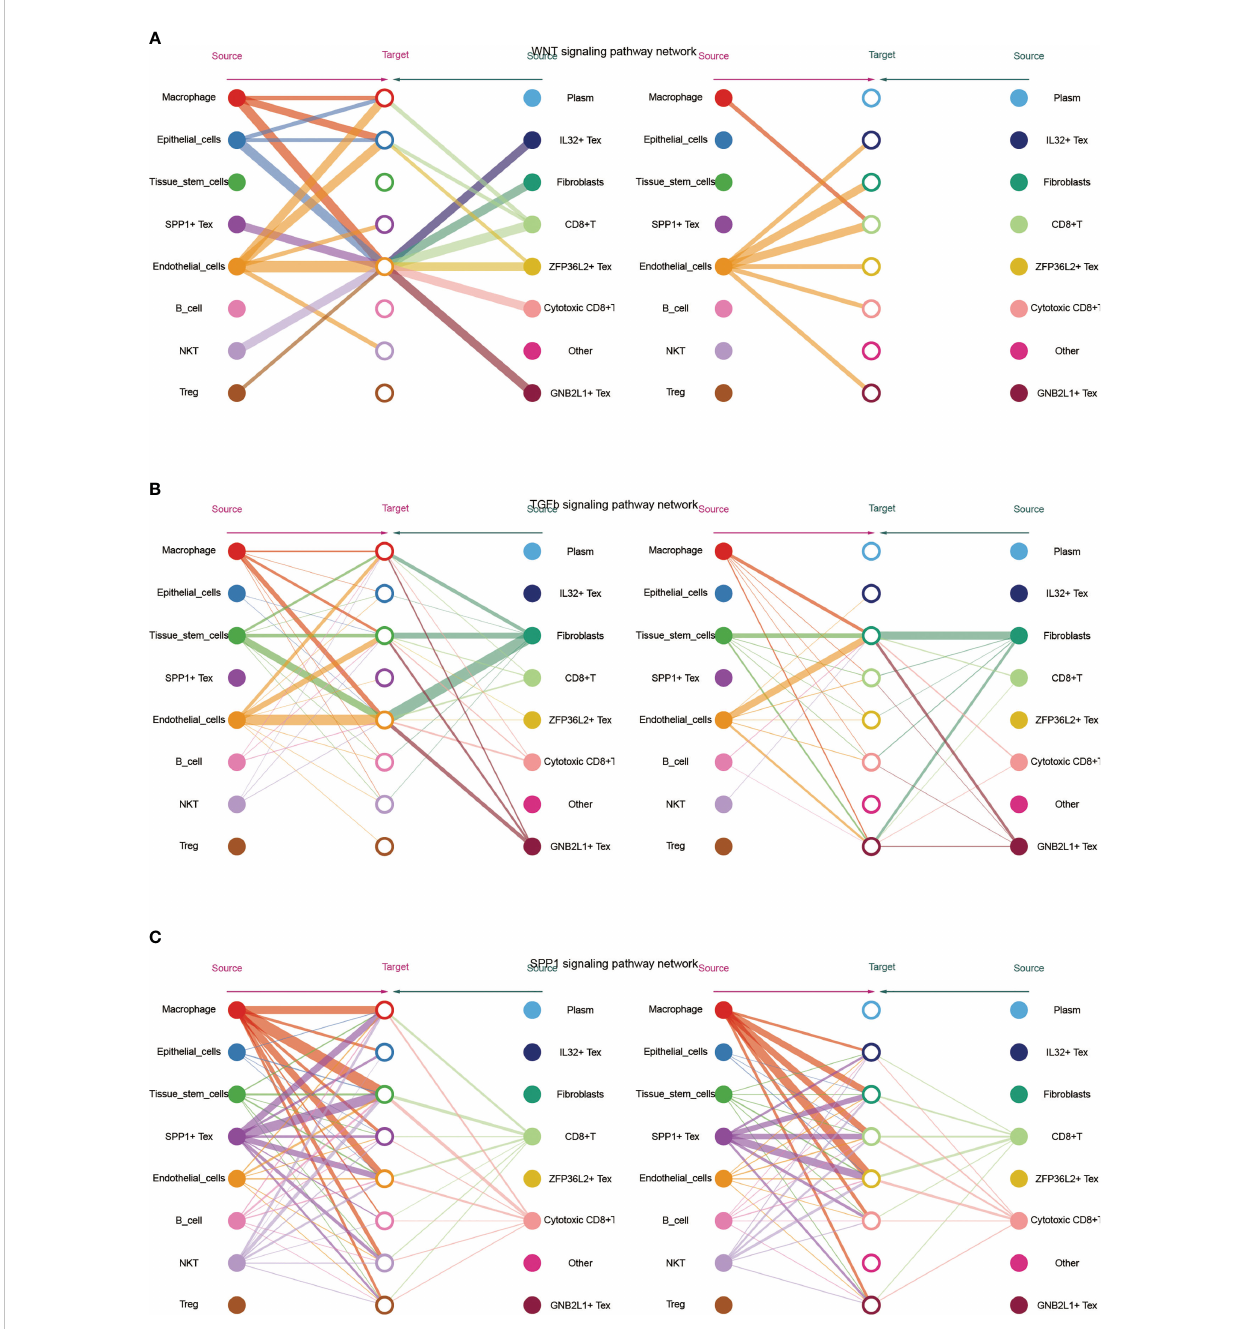
FIGURE 5 Network diagram showing (A) WNT, (B) TGF - b and (C) SPP1 related signaling pathways, respectively. The role of TGF- b -related pathways among all cells was shown by bubble plots, in which TGF- b 1 (TGF- b R1 + TGF- b R2) was generally more active among various types of cell communication (Figure 6A). In addition, analysis of the effect of related pathways between Tex cells showed that the effect of BMP4- and GDF5-related pathways differed between Tex cells, in which GNB2L1 + Tex actively interacted with stem cells, while SPP1 + Tex cells communicated mainly with stem cells through BMP4 (BMPR1B + ACVR2A) and GDF5 (BMPR1B + ACVR2A) (Figure